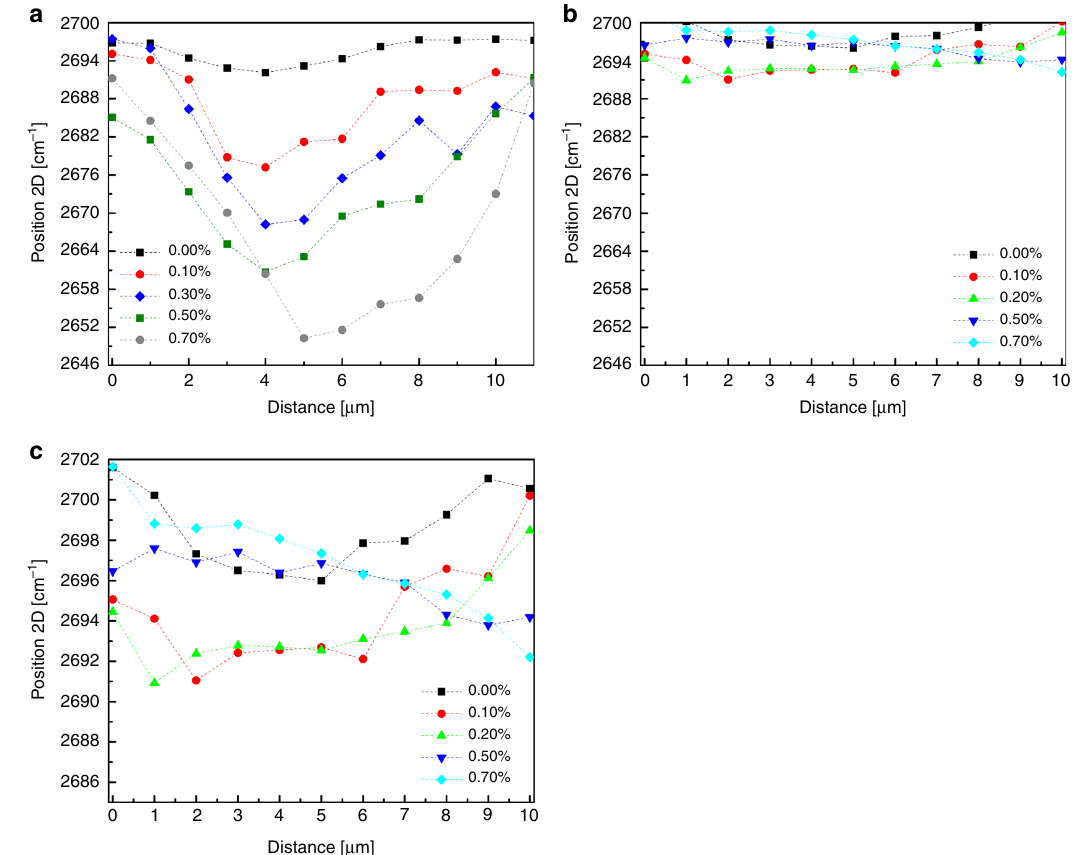
Fig. 3 Strain-transfer mechanism. Maps of the frequency of the 2D peak for various levels of strain showing the distribution pro fi le of the frequency of the 2D Raman peak across the length ( a ) of the bottom and ( b ) top single-layer graphene of the folded bilayer. In ( a ), ( b ), the data are plotted with the same scale on the y axis for comparison, and in ( c ), a zoom version of the results of ( b ) is presented for clarity. 0.50